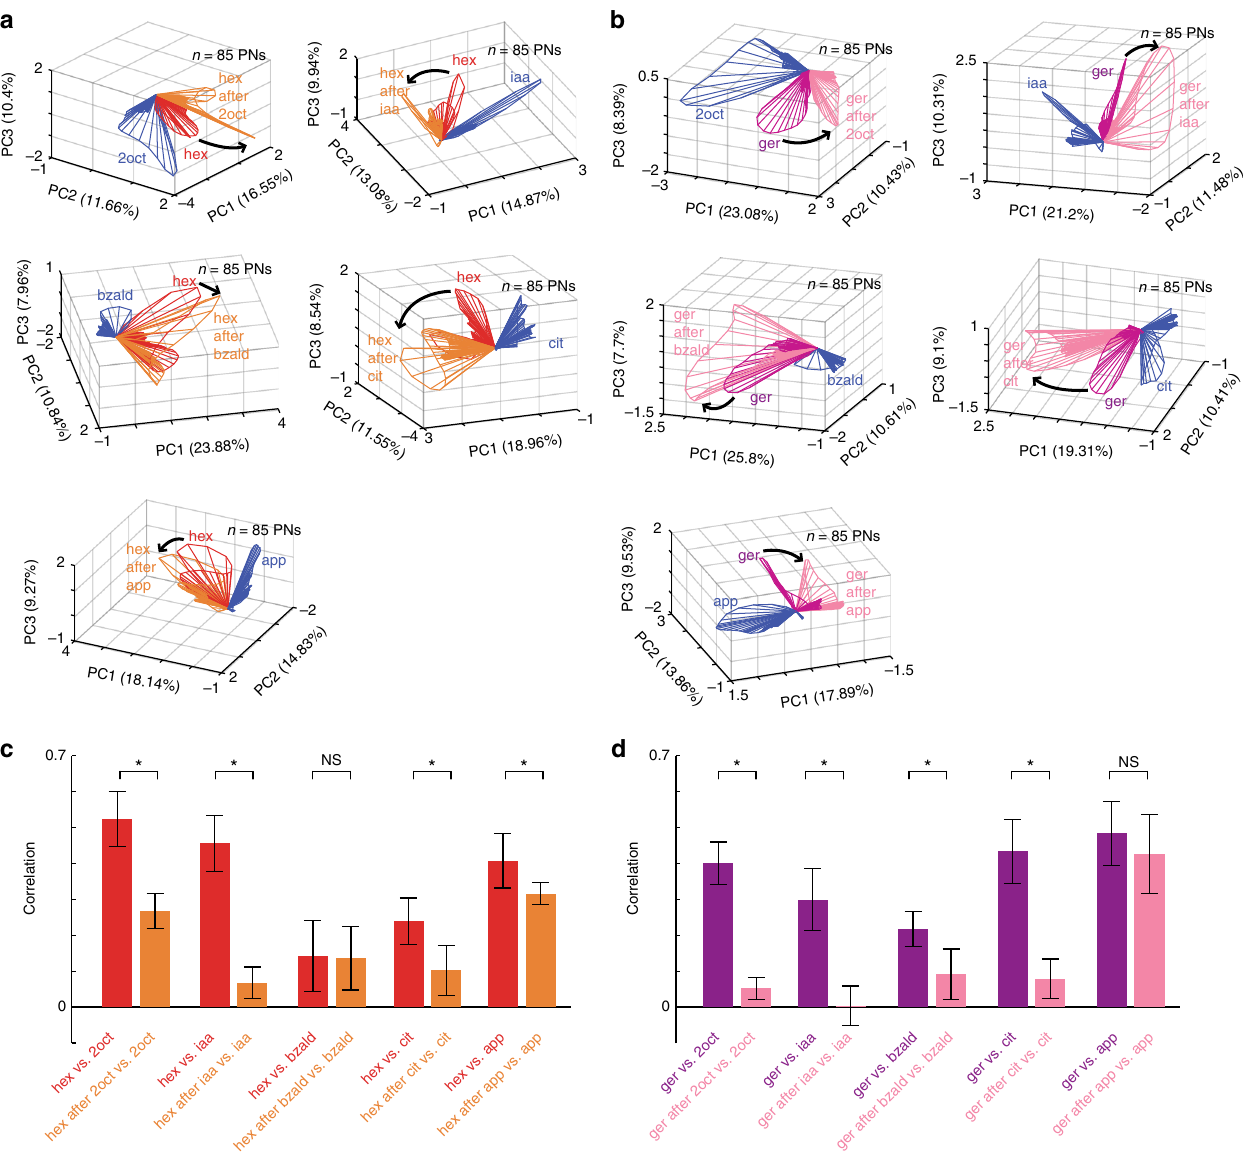
Fig. 2 Dynamic contrast enhancement of odor-evoked ensemble responses. a Similar trajectory plots as shown in Fig. 1e but comparing the population PN responses generated during solitary presentations of the distractor odorant (blue trajectory) and target odorant (red trajectory) with responses elicited by the same target odorant presented after the termination of the distractor cue (orange trajectory). Five plots are shown corresponding to hexanol introductions in the same fi ve stimulus sequences shown in Fig. 1a, c. Note that compared to the red trajectories, the orange trajectories are more distant from the blue trajectories in every panel. b Similar plots as in a are shown for fi ve sequential presentations of geraniol. It is worth noting again that compared to the solitary geraniol responses (purple trajectories), the responses observed during sequential presentations (pink trajectories) are more distant from the distractor cue evoked responses (blue trajectories) in every panel. c The mean of correlation values between the ensemble PN responses ( n = 85 PNs) evoked by hexanol and the fi ve distractor cues are shown as bar plots. Error bars indicate ± s.d. across ten trials. The mean odor-evoked responses during the initial 1 s after stimulus introduction was used for computing these correlations. Red bars quantify similarities between solitary distractor cue and solitary hexanol presentations. Orange bars indicate similarities between the solitary distractor cue and sequential hexanol presentations. Asterisks indicate a signi fi cant decrease in the correlation (* P < 0.05, NS: P > 0.05, paired t -tests, n = 10 trials). d Similar plots as in c but geraniol is used as the target